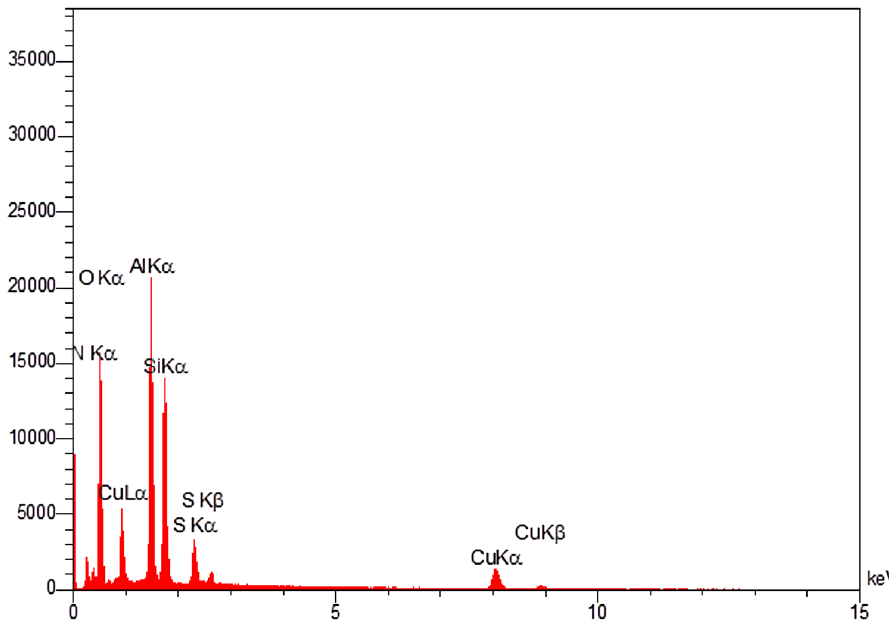
Figure 3. EDS diagram of